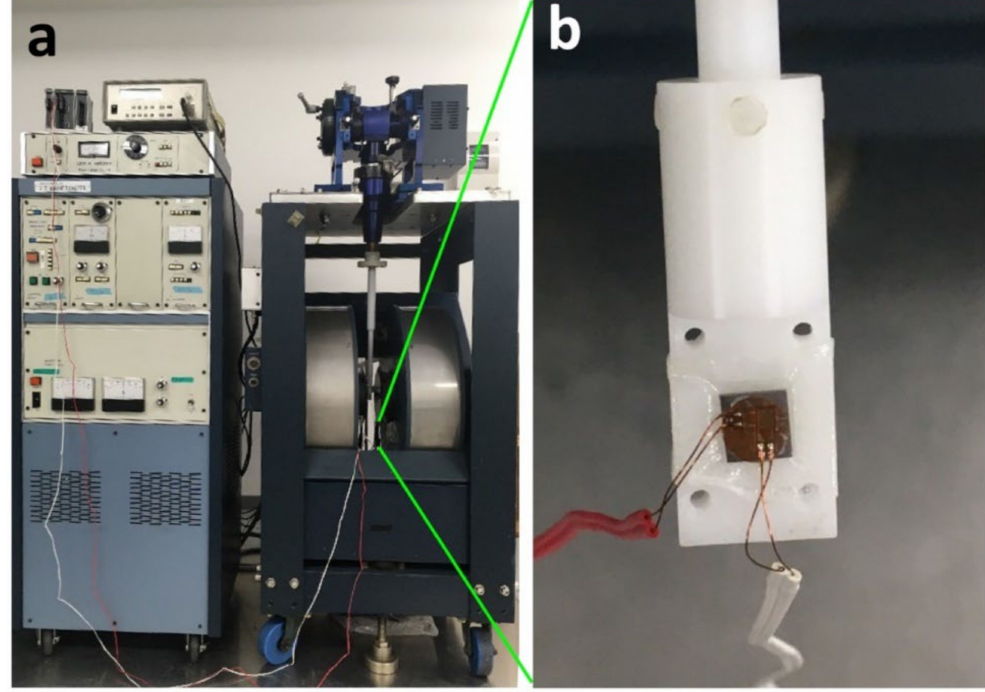
Figure 2. ( a ) VSM apparatus for magnetic and magnetostrictive measurements; ( b ) a two-axis strain